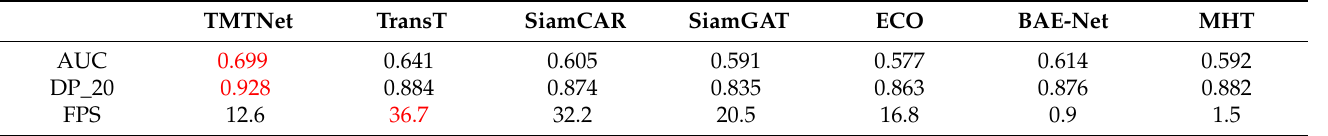
Table 2. AUC score, DP_20 value, and FPS of 7 trackers. The best result is labeled in red.